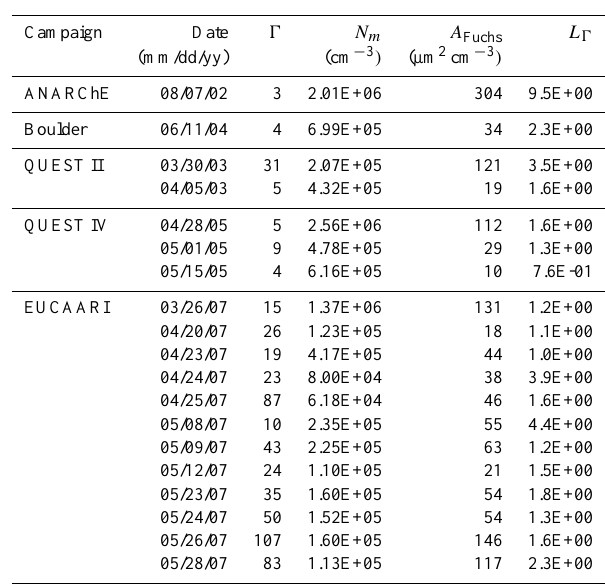
Table 2. Summary of relevant model parameters derived from mea- sured aerosol size distributions and sulfuric acid concentrations for nineteen non-events, characterized by the growth of pre-existing nanoparticles without new particle formation, acquired during the ANARChE (Atlanta), Boulder, QUEST II (Hyyti¨al¨a), QUEST IV (Hyyti¨al¨a), and EUCAARI (Hyyti¨al¨a) measurement campaigns. See text for parameter descriptions and calculations.